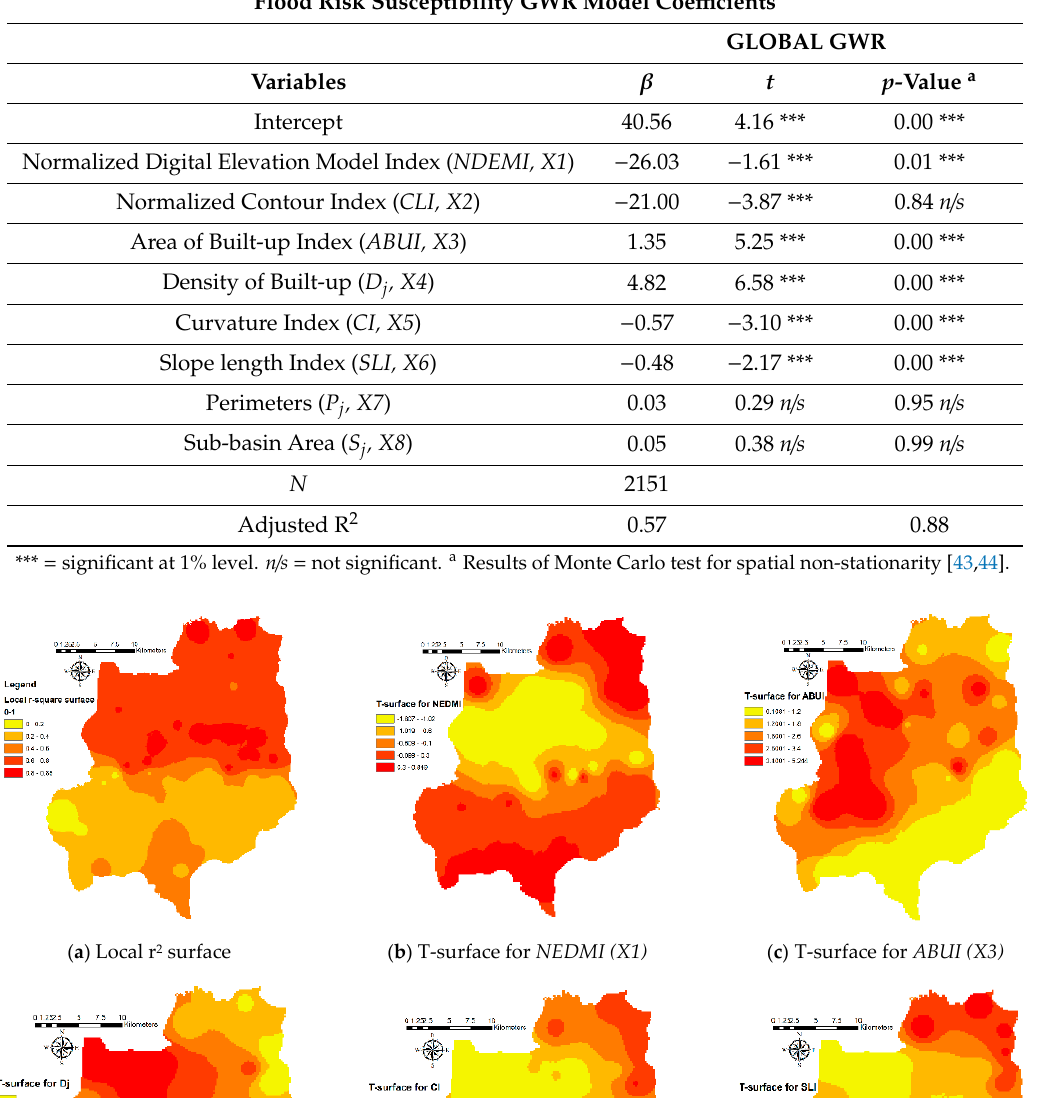
Table 6. ANOVA test of the FRS - GWR over the OLS regression model.